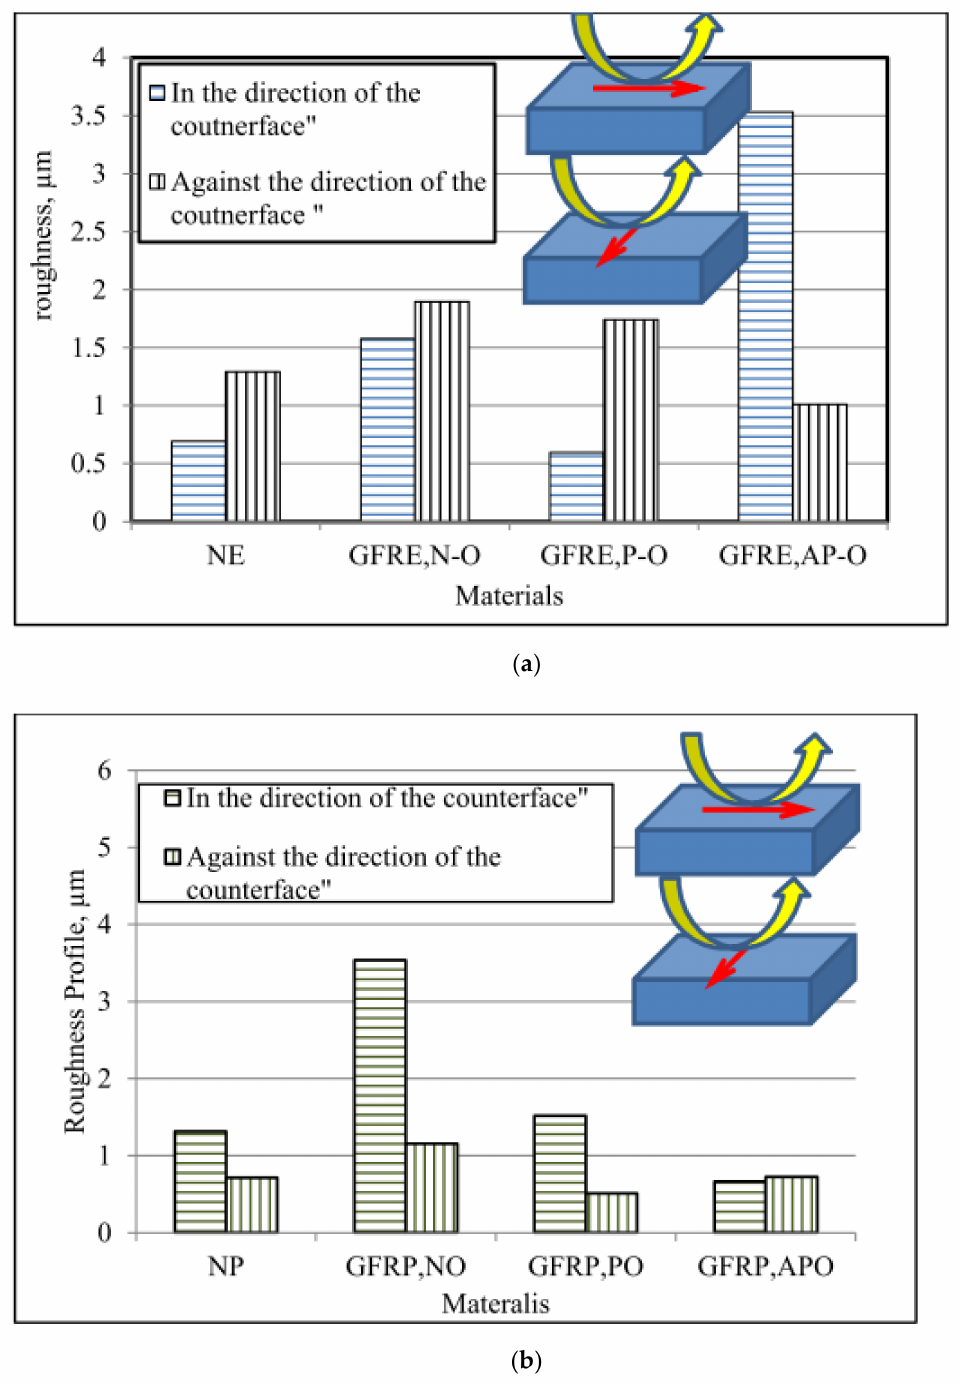
Figure 9. Roughness values of ( a ) GFRE and ( b ) GFRP under applied load of 30 N and sliding distance of 10–15